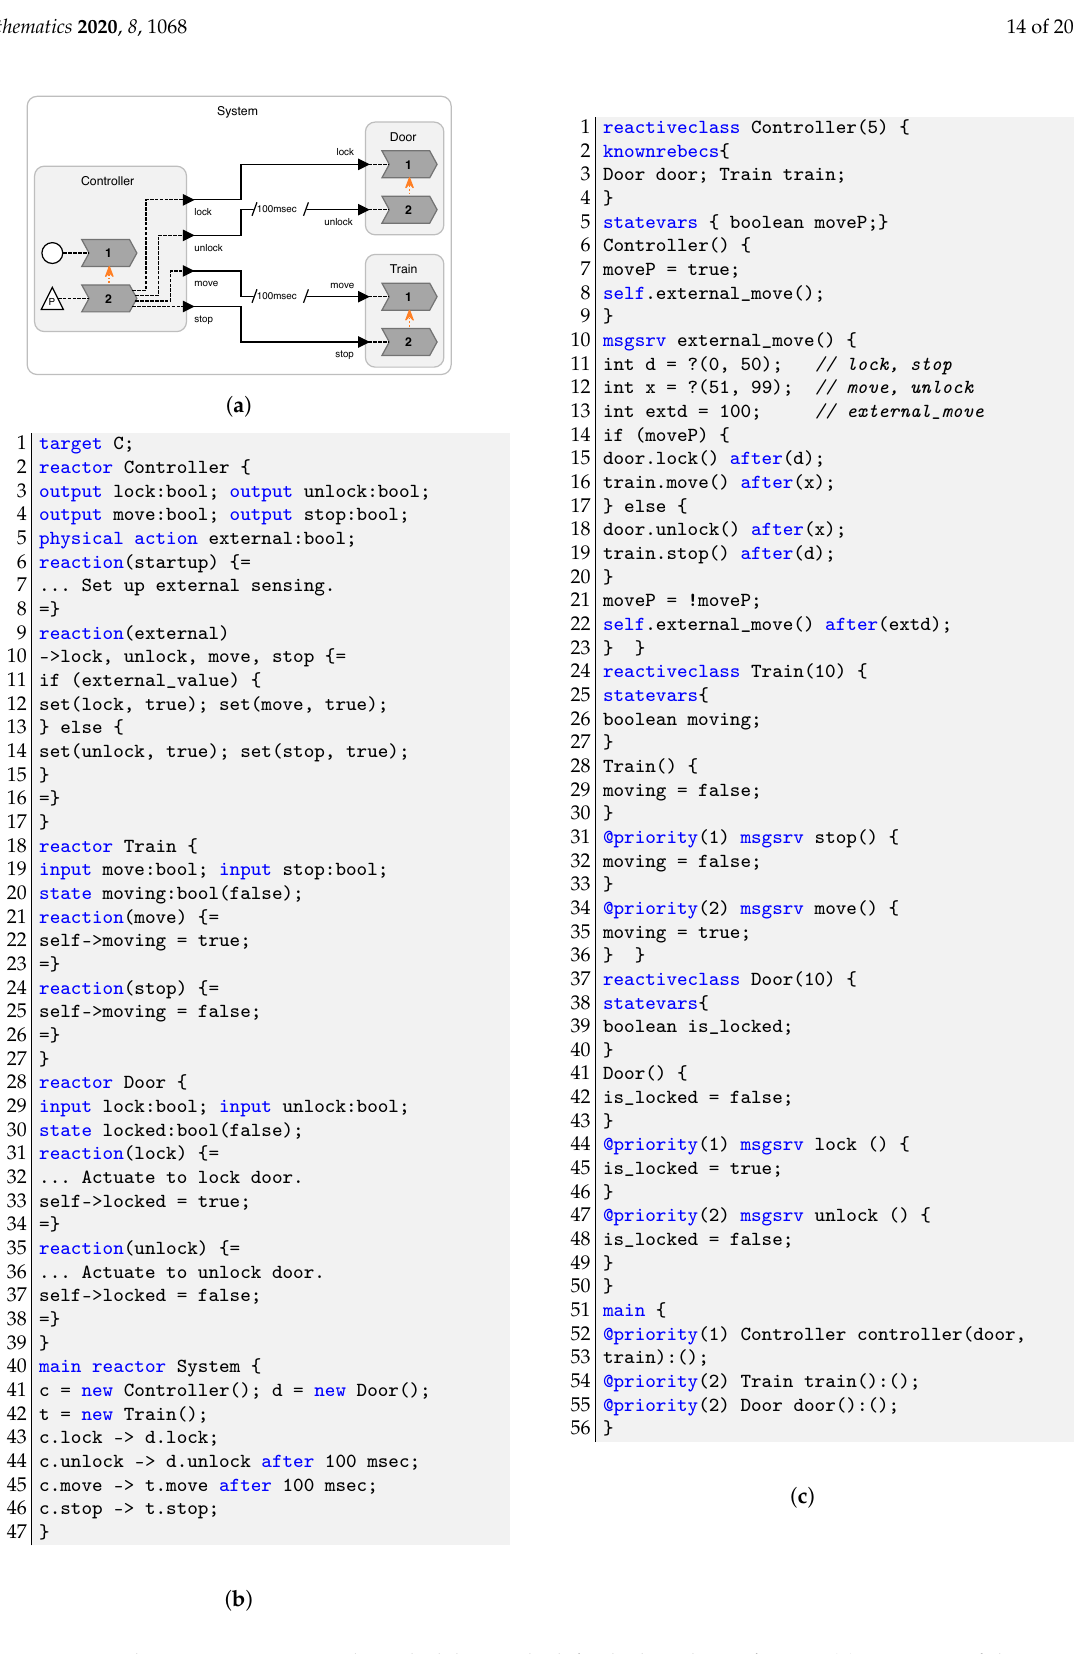
Figure 5. The Train Door Example with delays in lock/unlock and stop/move. ( a ) Structure of the door controller example. ( b ) Variant of Figure 2b that manipulates timetags. The values for after are set to 100. ( c ) The Rebeca model for the code in Figure 5b. Please note that here we put different values for after constructs compared to the LF code in Figure